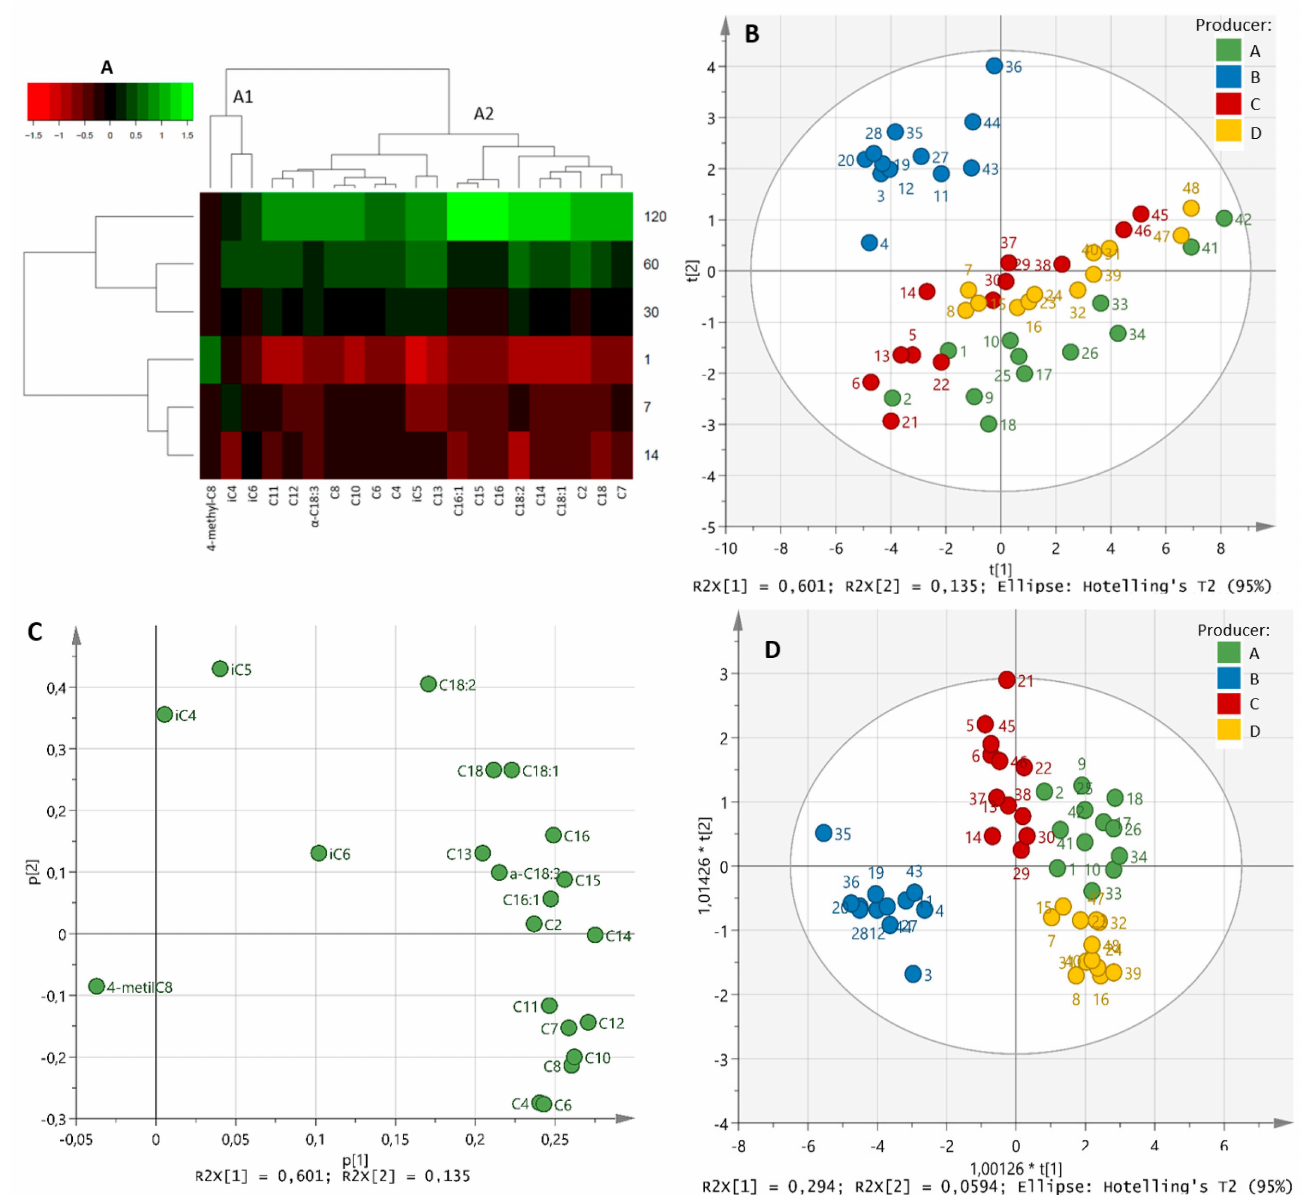
Figure 2. HCA heat map ( A ), scores and loadings plots of PCA ( B and C , respectively) and scores plot of the OPLS-DA based on the producer of the identified FFAs during ripening (1, 7, 14, 30, 60 and 120 days) ( D ). The scale values of the HCA correspond to log-transformed and UV scaled